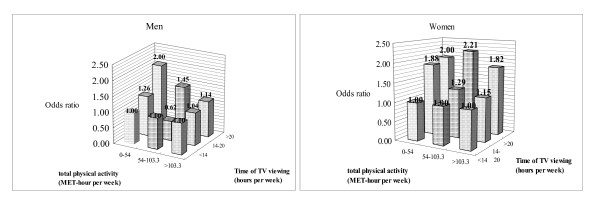
Effect of time of television (TV) viewing and total physical activity to the risk of metabolic syndrome by gender adjusted for age, educational level, household income and cigarette smoking habits. Groups for time of TV viewing (hours per week)was classified as < 14, 14–20, > 20 and total physical activity (MET-hr per week) as 0–54, 54–103.3, > 103.3.